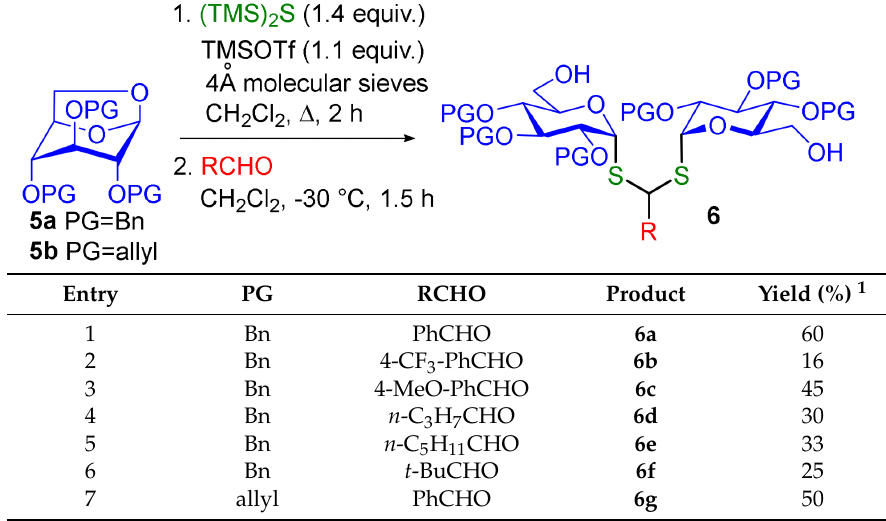
Table 2. Scope of aldehydes in the one-pot formation of dithioacetal- α , α